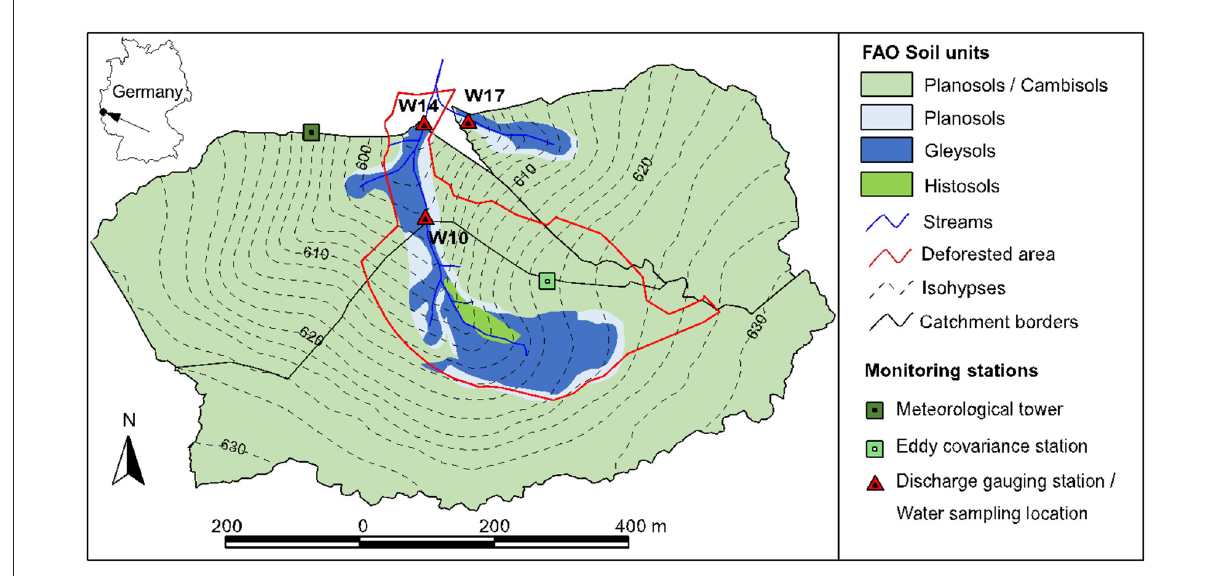
FIGURE1 Map of the Wüstebach headwater catchment and the adjacent, smaller reference catchment. Shown are the FAO soil units, isolines, streams, the eddy covariance station, and the meteorological station. The water sampling locations and discharge gauging stations are specified with red triangles and the extent of the deforestation is marked by a red border. The sub-catchment border has been derived from Stockinger et al. (2014).